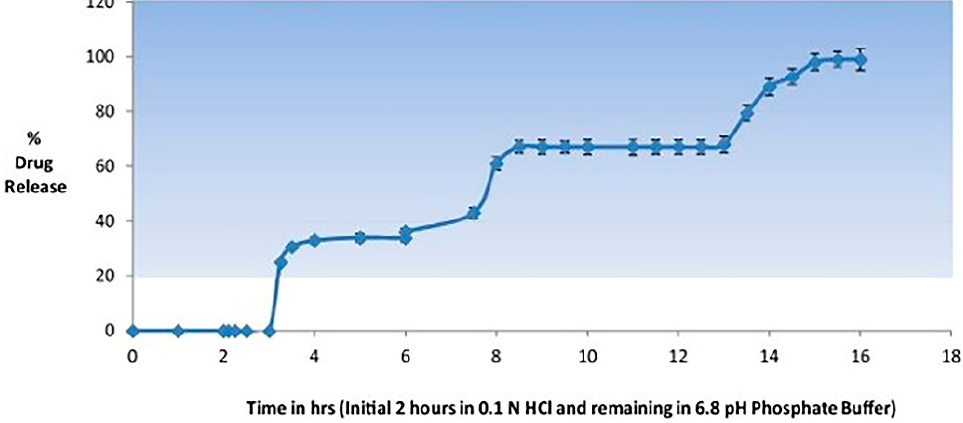
Figure 3. The in vitro drug release profile of enteric coated chrono-system with three pulsatile drug releases (adopted with permission from [65], Elsevier, 2016).